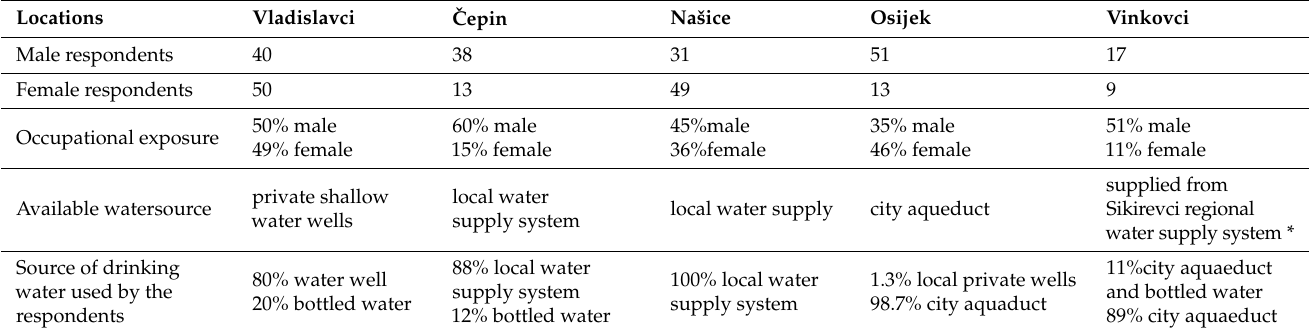
Table 2. Basic demographic characteristics of examinees and source of water used for